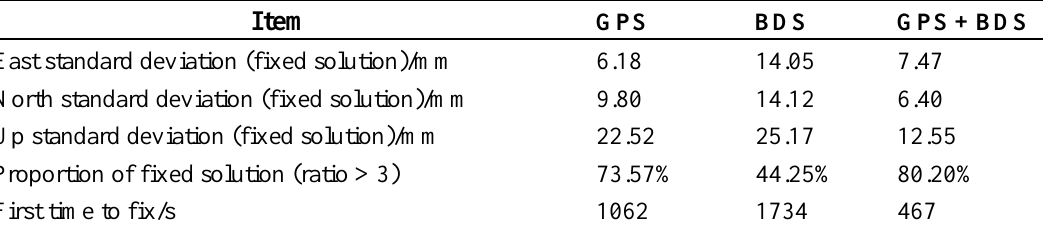
Table 4. Statistics of 9 km baseline